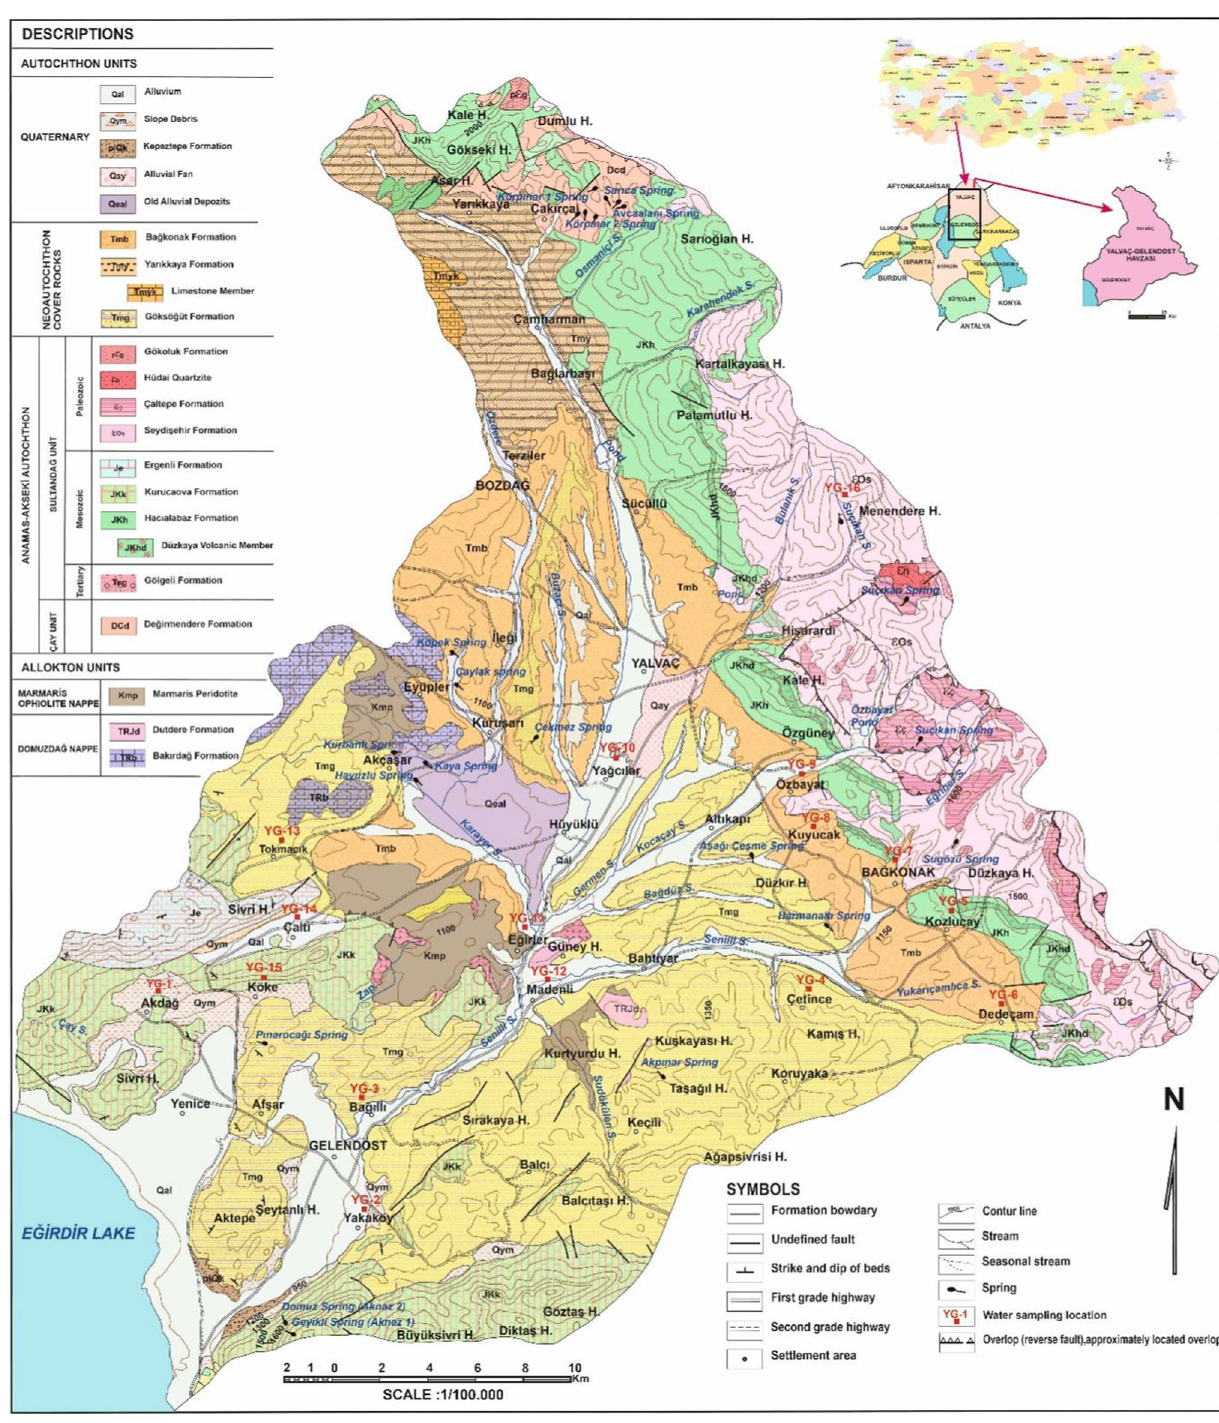
Fig. 1 Geological and location map of the Yalvaç–Gelendost